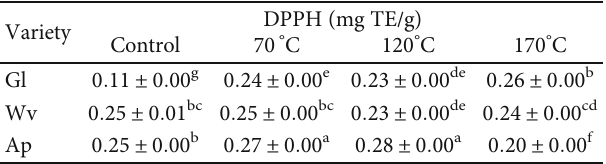
Values are presented as mean ± SD , n = 3 . Values having the same superscript letters are not signi fi cantly di ff erent ( p > 0 : 05 ). Scienti fi c names of the leafy vegetables have been abbreviated as follows: Gl: Gymnema lactiferum ; Wv: Wattakaka volubilis ; Ap: Argyreia populifolia